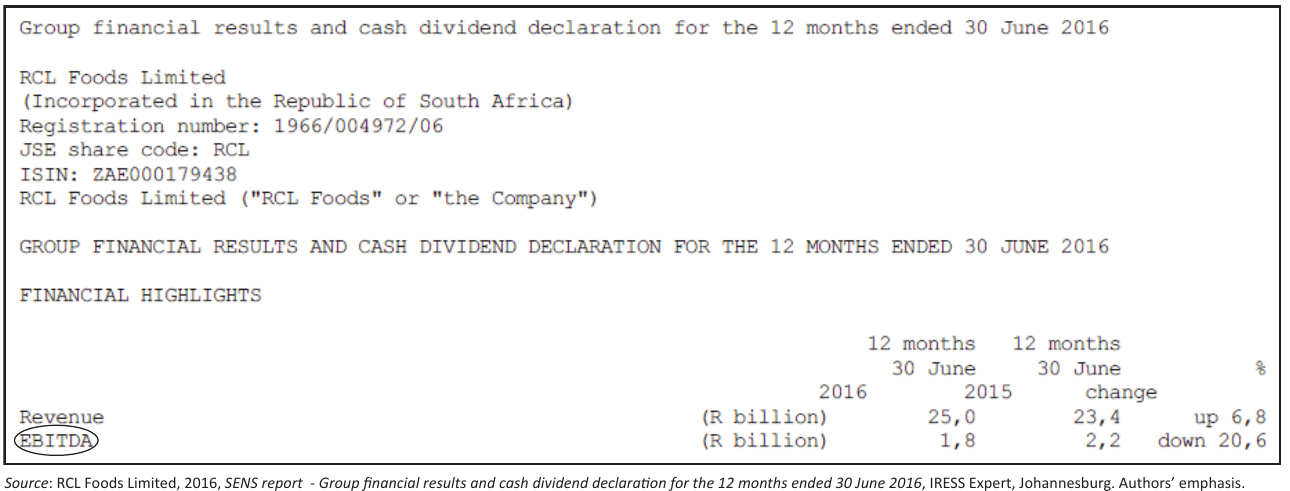
FIGURE 1: Extract from RCL Foods Limited 2016 Stock Exchange News Service report – Example of an unmodified earnings before interest, tax, depreciation and amortisation label.